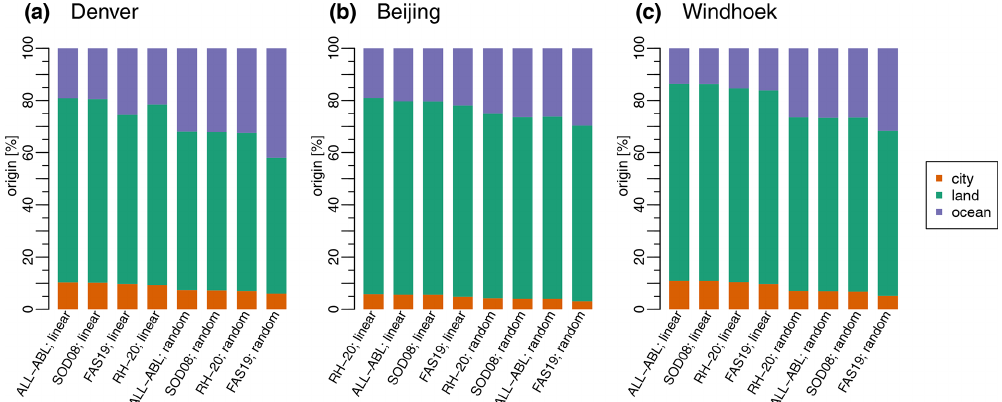
Figure 11. Origins of precipitation subdivided into local (orange), other land (green), and ocean (blue) source regions for (a) Denver, (b) Beijing, and (c) Windhoek, averaged over the period 1980–2016, as well as for different E detection criteria (RH-20; SOD08; ALL- ABL; FAS19) and attribution methods (linear discounting and attribution; random attribution) along the columns. City origins indicate the percentage of heat originating from a 3 ◦ × 3 ◦ box around the center of each city (i.e., local origins). Columns are sorted in descending order of the local contributions (orange